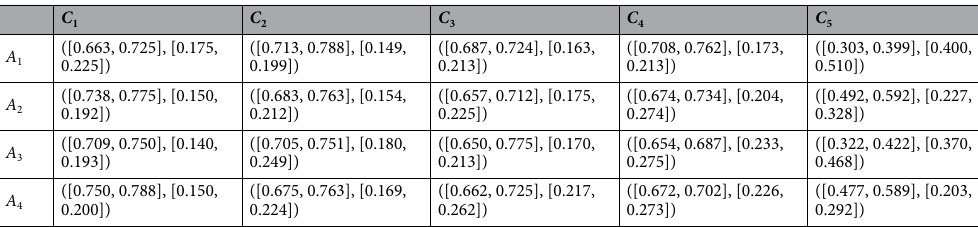
Table 7. Interval-valued intuitionistic fuzzy group decision